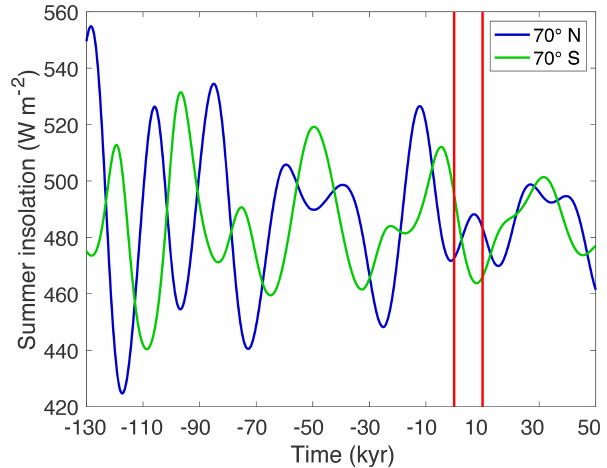
Figure 4. Summer insolation at 70 ◦ N (June) and 70 ◦ S (Decem- ber) from 130kyr ago at the onset of the last interglacial to the next 50kyr. The period of our study is highlighted with vertical red